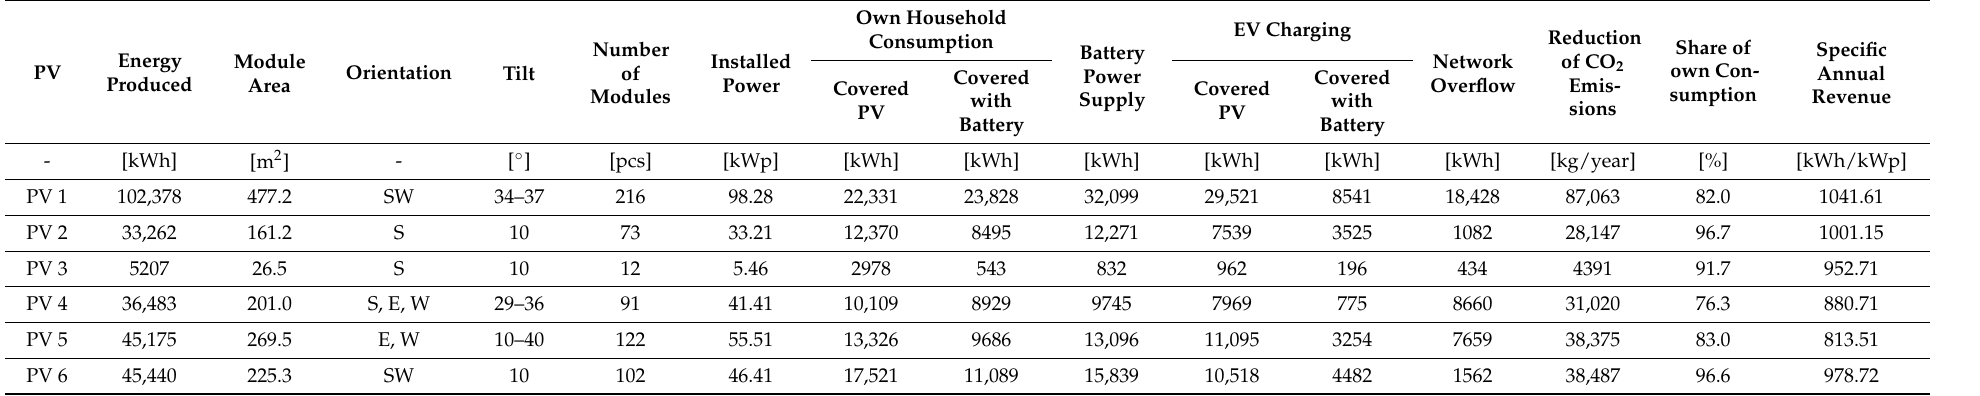
Table 20. Energy from photovoltaic power plants and the distribution network.